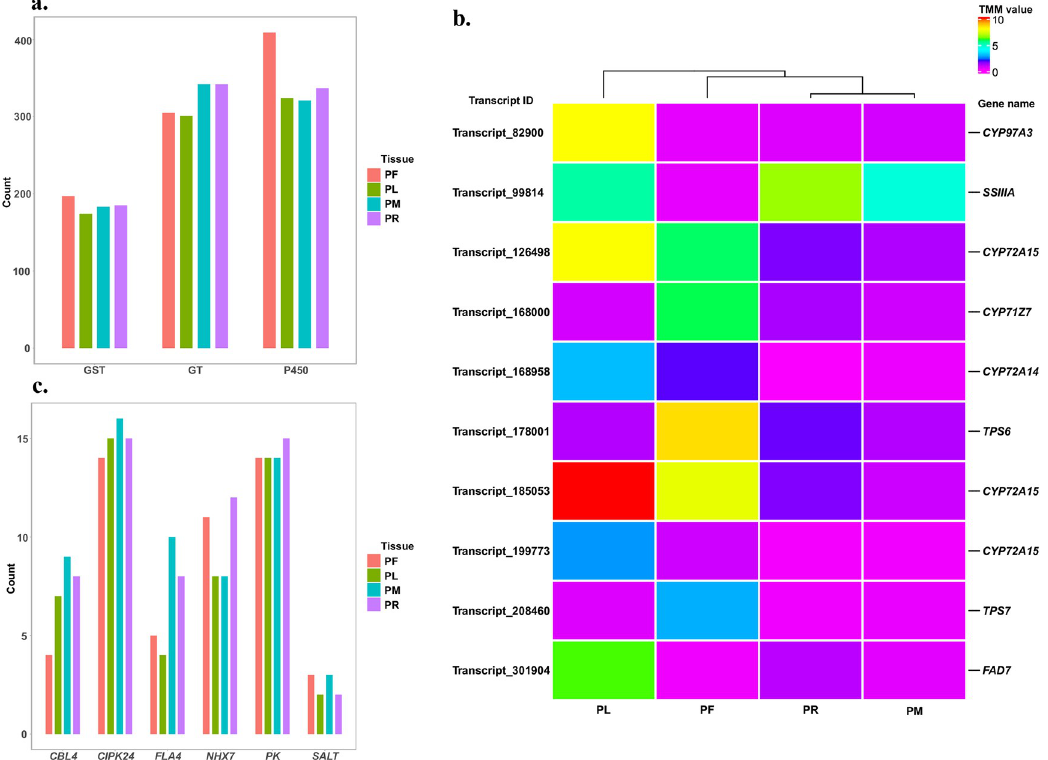
Fig 8. Identification of herbicide- and salinity-resistant genes and analyses. a. Distribution of transcripts with the domain from three types of the herbicide-resistant gene families among four tissues in P . australis transcriptome; b. Distribution of transcripts annotated as six types of the salinity-resistant genes among four tissues in P . australis transcriptome; a-b, if the transcript has the expression in that tissue from the normalized expression matrix, it would be counted; c. Heatmap of the transcripts predicted as herbicide-resistant genes with tissue-specific expression patterns. Gene name is from the UniProt-Swissprot annotation. Heatmap was generated from the R package ComplexHeatmap [53]. Red depicts a higher TMM value and purple depicts a lower TMM value. PL: leaf, PF: inflorescence, PM: shoot meristem, and PR: